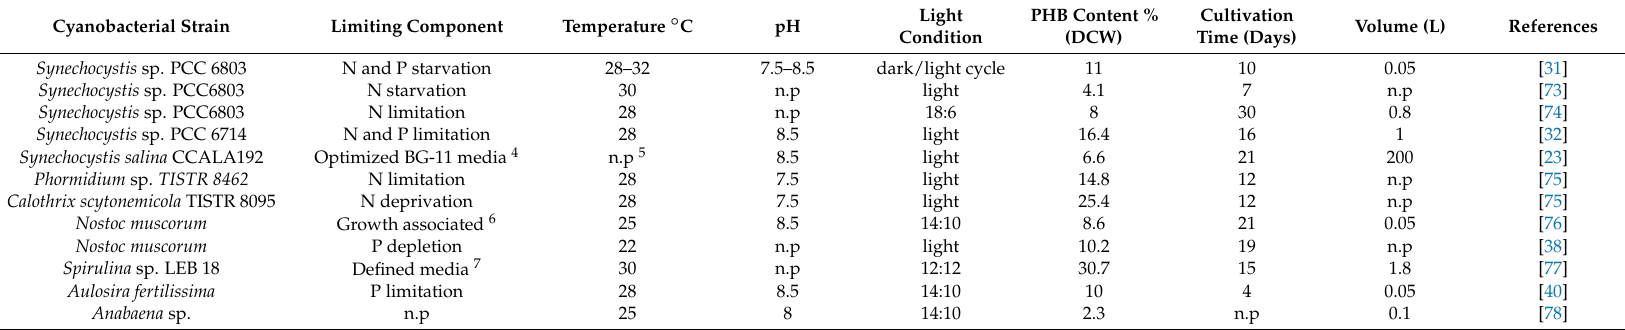
Table 3. Reported cultivation parameters and media limitation used for photoautotrophic PHB production in wild-type cyanobacterial strains. Cyanobacterial Strain Limiting